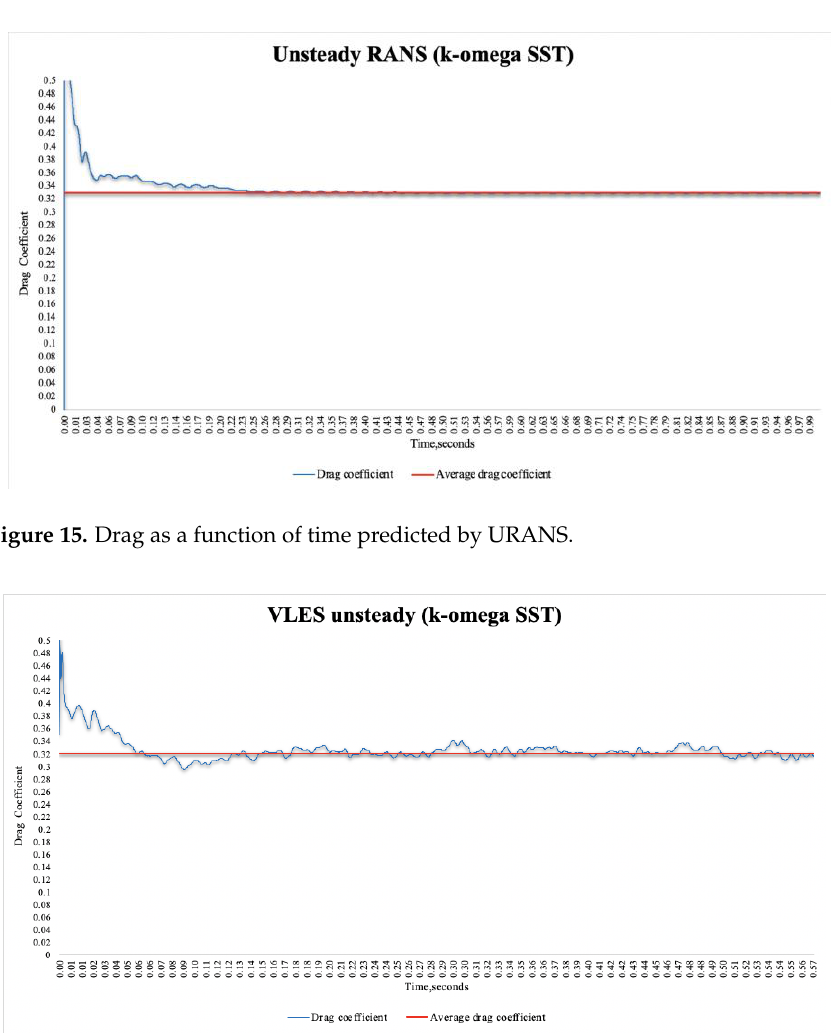
Figure 16. Drag as a function of time predicted by VLES.